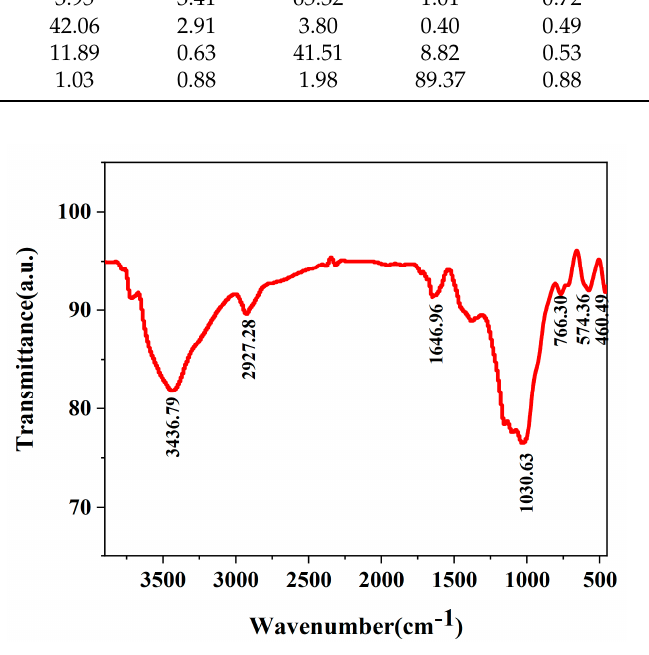
Figure 1. FTIR spectra of SBT with a resolution of 0.4 cm − 1 .